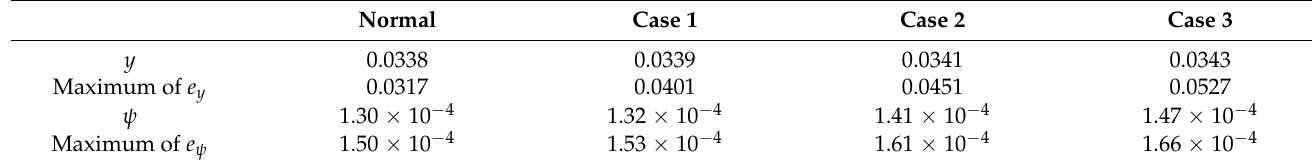
Table 5. Comparison under various